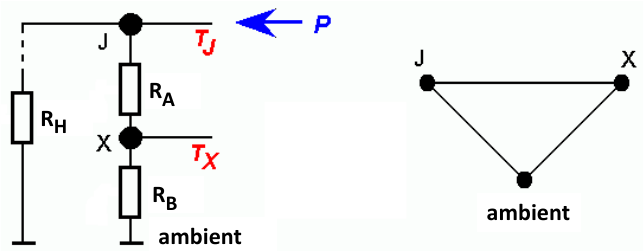
Figure 2. A simple network model for interpreting a partial thermal resistance between a single heat source and a reference point.